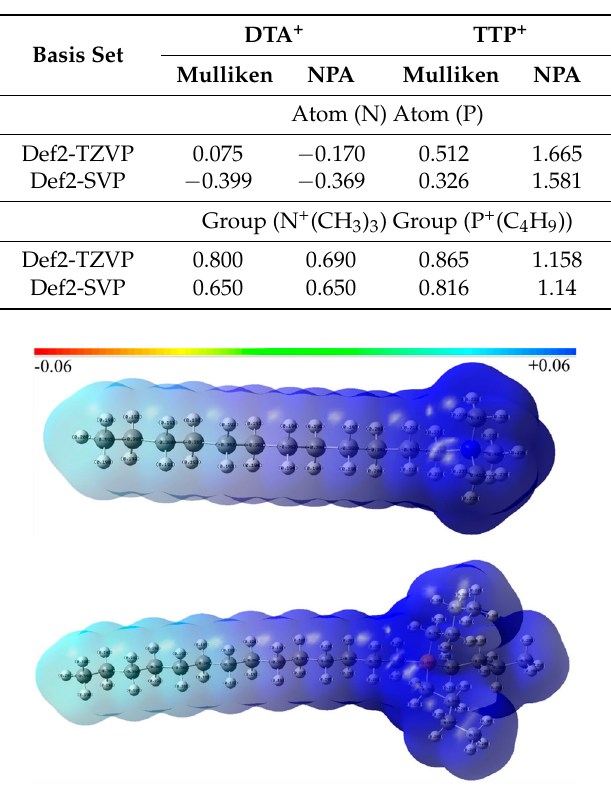
Figure 5. Diagrams of isostatic potential (electronic density) distribution of DTA + ( Top ) and TTP + ( Bottom ) at wB97XD/Def2-TZVP level.